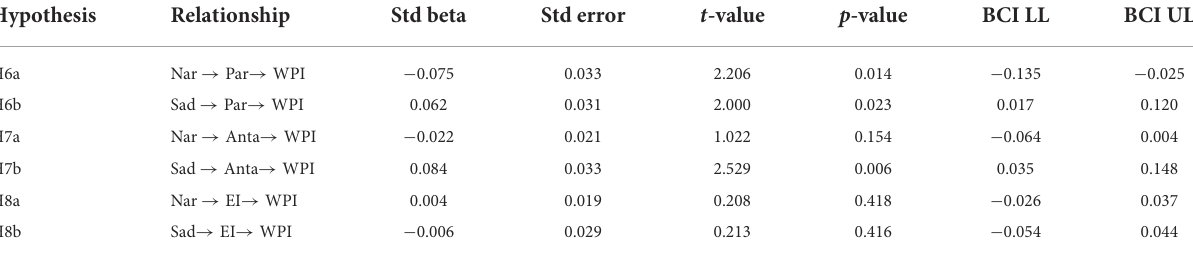
TABLE 5 Hypotheses testing (indirect